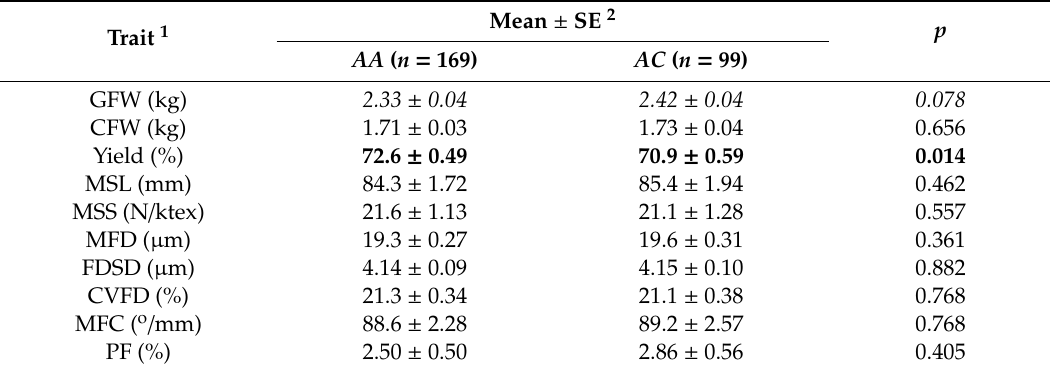
Table 1. E ff ect of KRTAP21-1 genotype on various wool